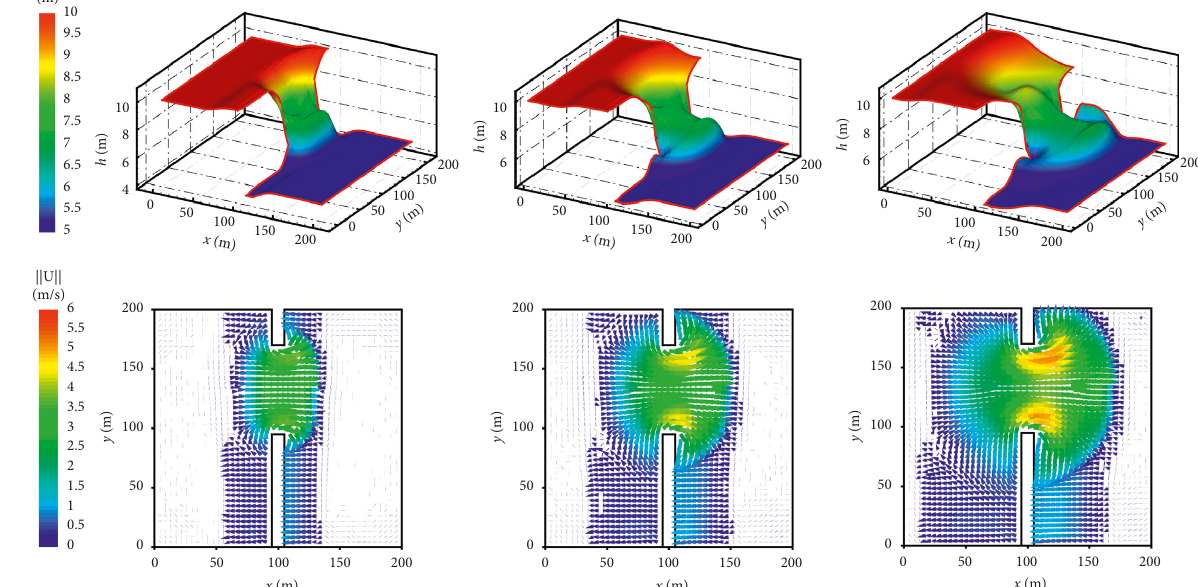
Figure 4: The profile of water depth and velocity vectors of the 2D dam break at different output times: t